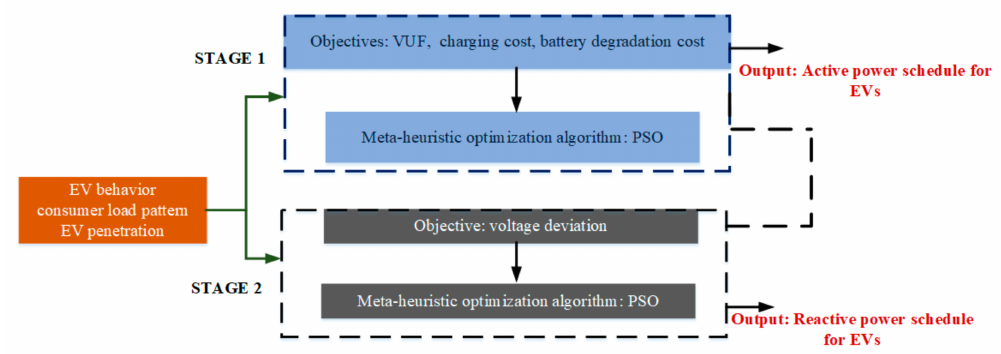
Figure 2. Proposed method to schedule